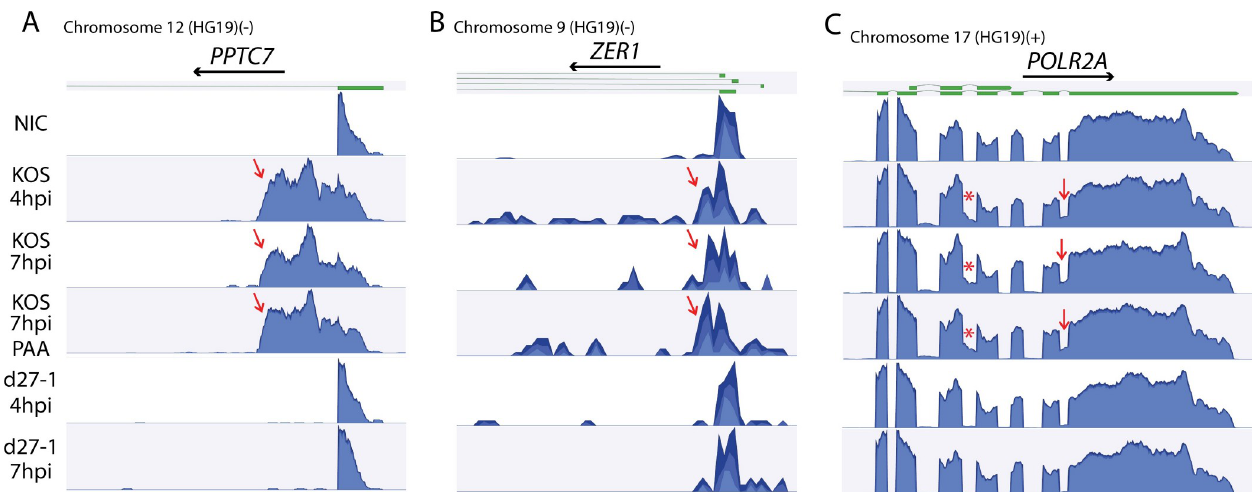
Fig 2. HSV-1 ICP27 causes aberrant pre-mRNA processing of cellular transcripts in infected cells in a gene/sequence specific manner. RNA-seq data from wild-type HSV or ICP27 deletion mutant infected HEK- HEK-293 cells were aligned to the human genome HG19 reference sequence using CLC Genomics Workbench. Representative genes for which co-transcriptional pre-mRNA processing is modulated in ICP27 expression plasmid-transfected cells [20] are provided as examples and shown in ( A ) Use of cryptic PAS in intron 1 of PPTC7 (negative strand), ( B ) Use of cryptic 5’ss in intron 1 of ZER1 (negative strand), and ( C ) Last intron retention in POLR2A (positive strand), supporting previous findings in HSV-2 ICP27 transfected cells [20]. Retention of intron 24 of POLR2A (labelled as � ) was not previously observed in HSV-2 ICP27 expression plasmid transfected cells. Previously described transcript isoforms (thick green lines on top of the graphs denote exons) are shown above each graph. Low level read counts mapping downstream of the cryptic 5’ss of ZER1 suggest that there is likely a low level of intron retention coupled with aberrant use of the cryptic 5’ss. Arrows indicate significant differences in intronic read counts in KOS vs d27-1 infected cells. NIC: noninfection control.